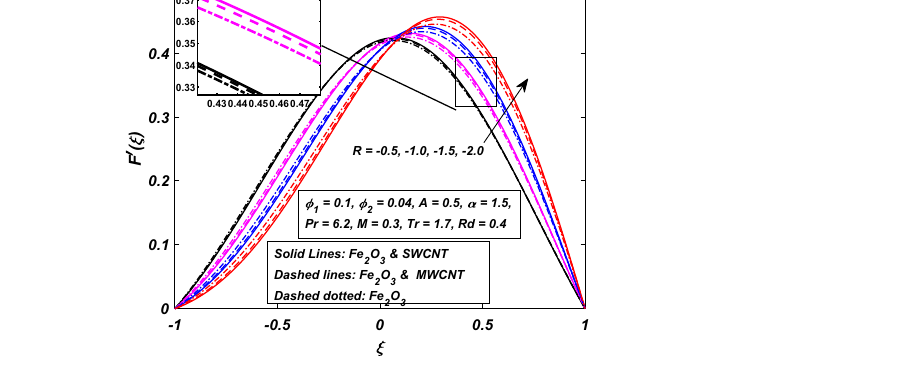
Figure 5. Influence of − R on F ′ (ξ) .